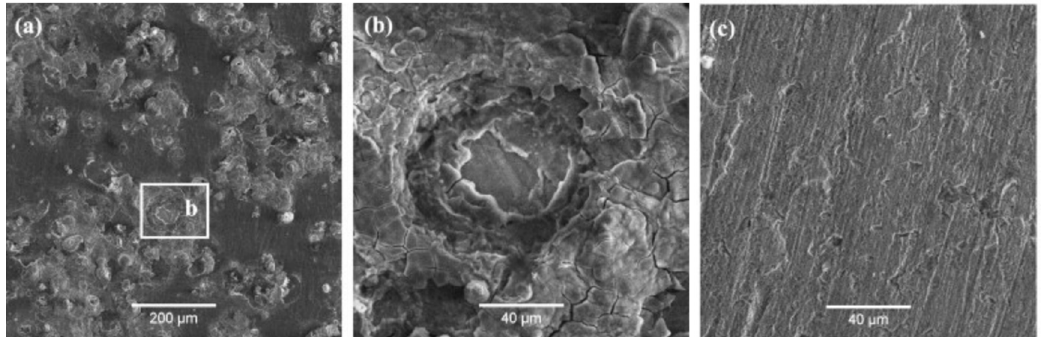
Figure 12. SEM micrographs for ( a ) and ( b ) Fe-Mn-Al-Si, and ( c ) interstitial-free (IF) steel after polarization experiments in 0.1 M NaOH [108]. (Reproduced with permission from refs. [108]. Copyright (2008), Elsevier).